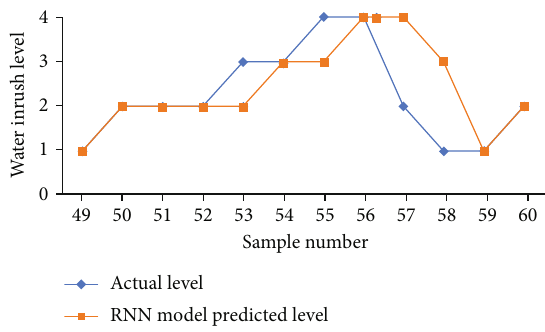
Figure 6: Prediction results of the RNN